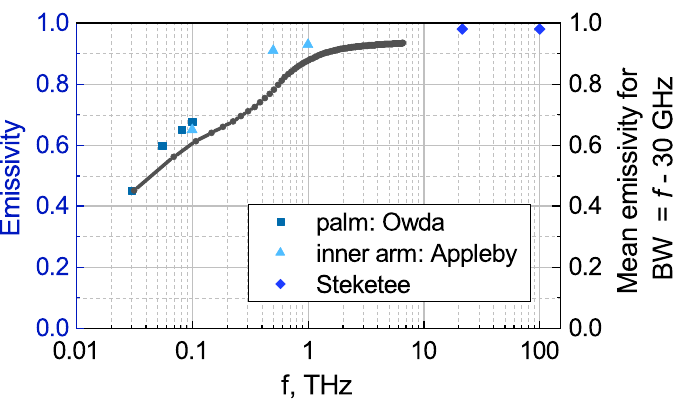
Figure 7. Emissivity of human skin at various frequency ranges, as given in Reference [52] (diamonds), Reference [51] (triangles) and Reference [48] (squares). Grey dots connected by a grey line show the mean emissivity over the bandwidth BW = f − f 0 = f − 30 GHz, were f is the frequency of the x -axis, and f 0 = 30 GHz is the lower bound of the detection